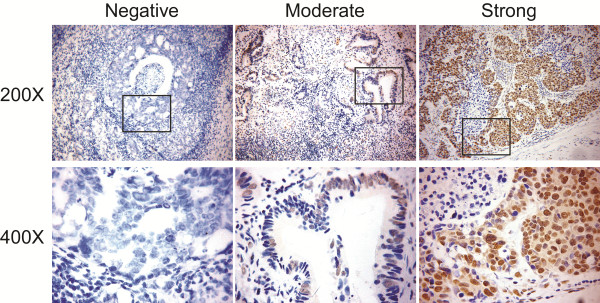
Immunohistochemical analysis of Sam68 expression in metastatic lymph node tissues from colorectal cancer (CRC) patients. Negative, moderate or strong Sam68 staining was observed in CRC metastatic lymph node tissues.